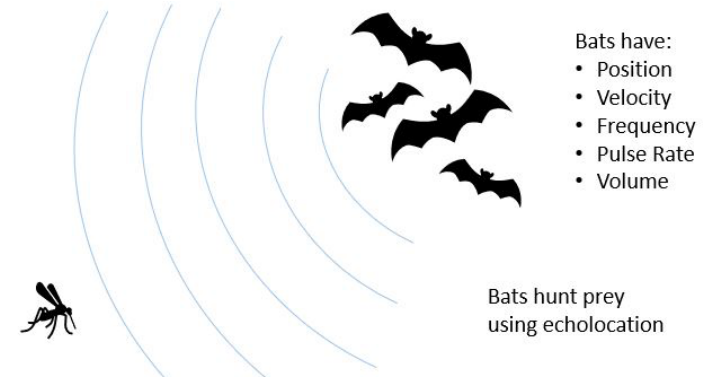
Figure 2. Visualization of the Bat Algorithm. The Bat Algorithm is inspired by the natural hunting behavior of bats. The algorithm captures this by giving each bat a the set of variables pictured on the right. These variables and their interaction are formalized in Section 2.2.